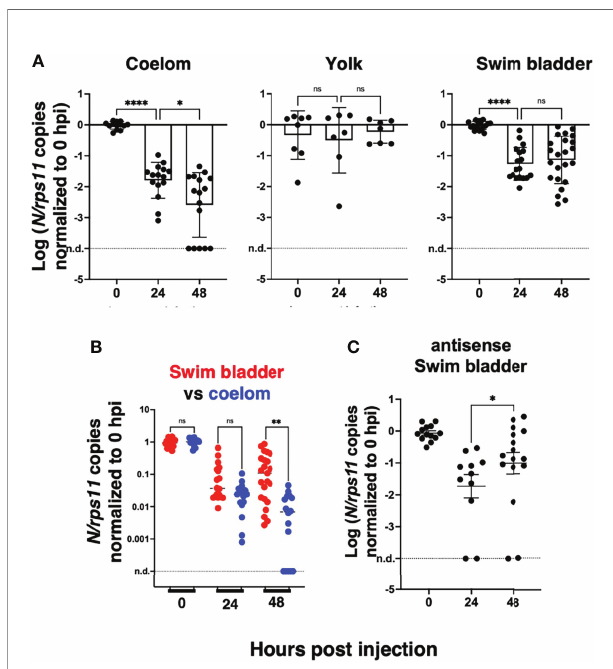
FIGURE 4 | Statistical analysis of viral transcript quanti fi cations, after normalization to the means of values measured at 0 hpi for each experiment. (A) Comparison of SARS-CoV-2 RNA loads over time in each microinjection location; ANOVA analysis of log-transformed values, not assuming equal SDs (Brown – Forsythe test with Dunn ’ s correction). Results pooled from four, two, and fi ve experiments for coelom, yolk, and swim bladder injections, respectively. (B) Comparison of coelom and swim bladder injections at each time point; non-parametric multiple comparisons of non-transformed values (Kruskal – Wallis test with Dunn ’ s correction). (C) Comparison of antisense transcripts in the swim bladder, log-transformed values, Mann – Whitney test, pooled from three experiments. ns, not signi fi cant; *p < 0.05; **p < 0.01; ****p <